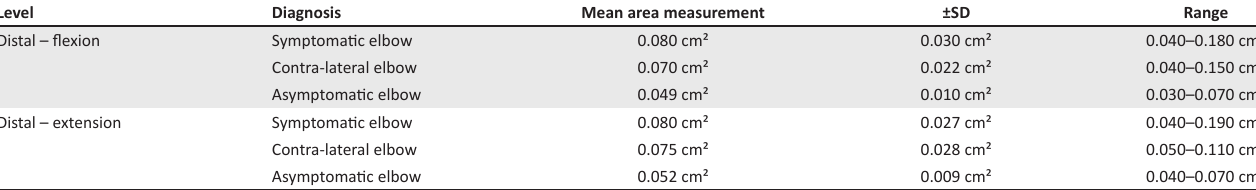
TABLE 2a: Comparison of cross-sectional area measurements of the ulnar nerve, 50 mm distal to the level of the cubital tunnel. Level